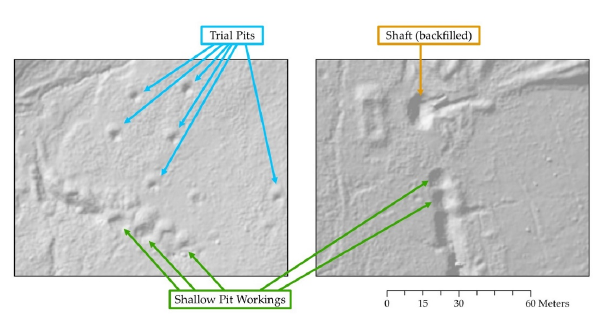
Figure 1. Example of the types of mining features the model was trained to detect. LiDAR visualisation is a 315 ˚ azimuth 35˚ sun elevation hillshaded visualisation. Image originally published in Gallwey et al. (2019). Base DSM © Environment Agency 2015 Dartmoor National Park is underlain by the Dartmoor